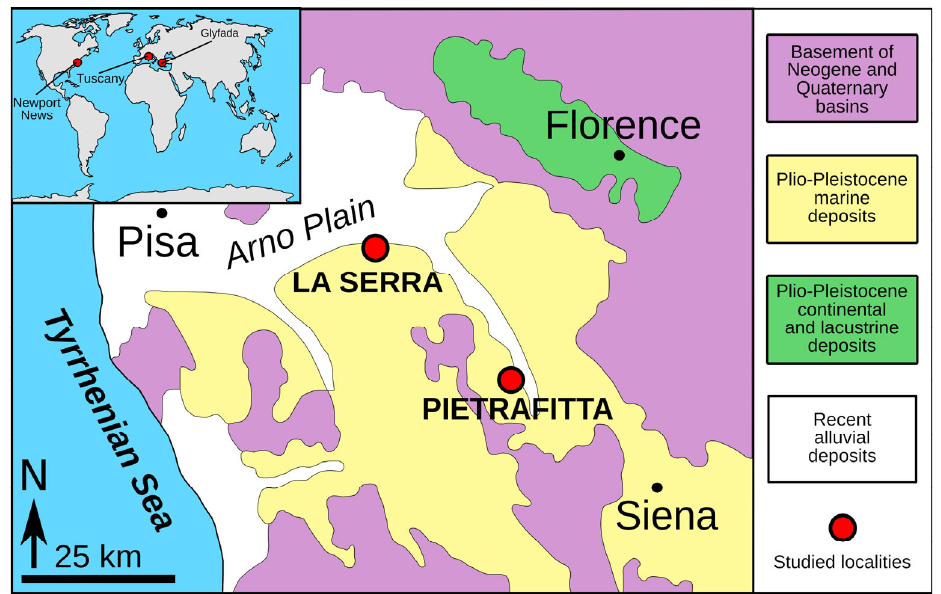
Figure 1. Map with the location of the studied specimens. Upper left inset panel indicates the position of the samples across the globe. The main panel provides the position of the samples from the Tuscan Pliocene in the framework of a simplified regional geological map.